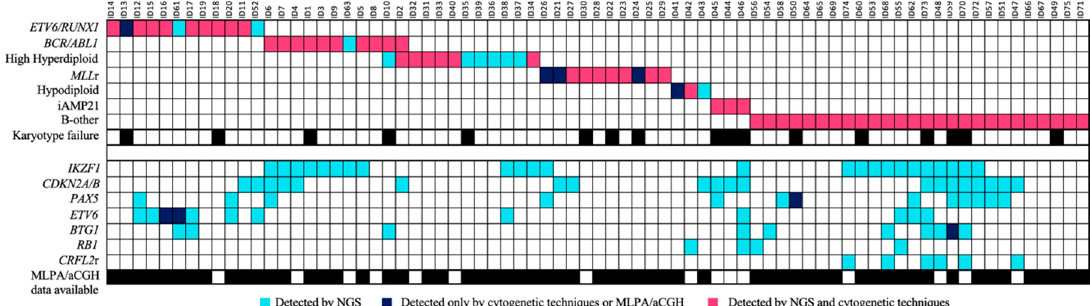
Figure 7. Genetic findings from the combined analysis of the custom NGS panel and standard-of- care diagnostics. The figure summarizes the genetic alterations observed in the series of B-ALL patients, where columns and rows represent patients and genetic alterations, respectively. The upper box shows the alterations that allow patients to be classified by biological risk groups. Turquoise, dark-blue, and pink boxes, respectively, indicate the alterations detected exclusively by the custom NGS panel and cytogenetic techniques and those detected by both. In the lower box, the different secondary alterations detected correspond to the loss of the genes indicated in the different rows and to the rearrangements of the CRFLF2 gene. Supplementary Materials: Additional information is available online at http: // www.mdpi.com / 2075-4426 / 10 / 3 / 0137 / s1. Table S1: Genetic characteristics of the patients; Table S2: Clinical and demographic characteristics of the patient cohort; Table S3: List of genes included in the panel design for mutation analysis; Table S4: Chromosomal regions for detecting gene fusions; Table S5: Chromosomes mapped to aneuploidy detection; Table S6: Genes for CNV detection; Table S7: Pharmacogenomic SNPs included; Table S8: Genes included in the targeted TruSeqCustom amplicon (TSCA) panel for ALL (pre-beta test plan for Illumina); Table S9: Oligonucleotide pair for detecting gene fusions; Table S10: List of variants detected in duplicate-sequenced samples; Table S11: Sensitivity and specificity of detection of different types of alterations; Table S12: List of detected mutations; Table S13: Mutations described in REH cell line; Table S14: Frequency of pharmacogenetic SNPs detected in the patient cohort; Figure S1: Frequency of trisomies in high hyperdiploidy cases; Figure S2: t(5;12)(q35;p13) visualized with IGV.